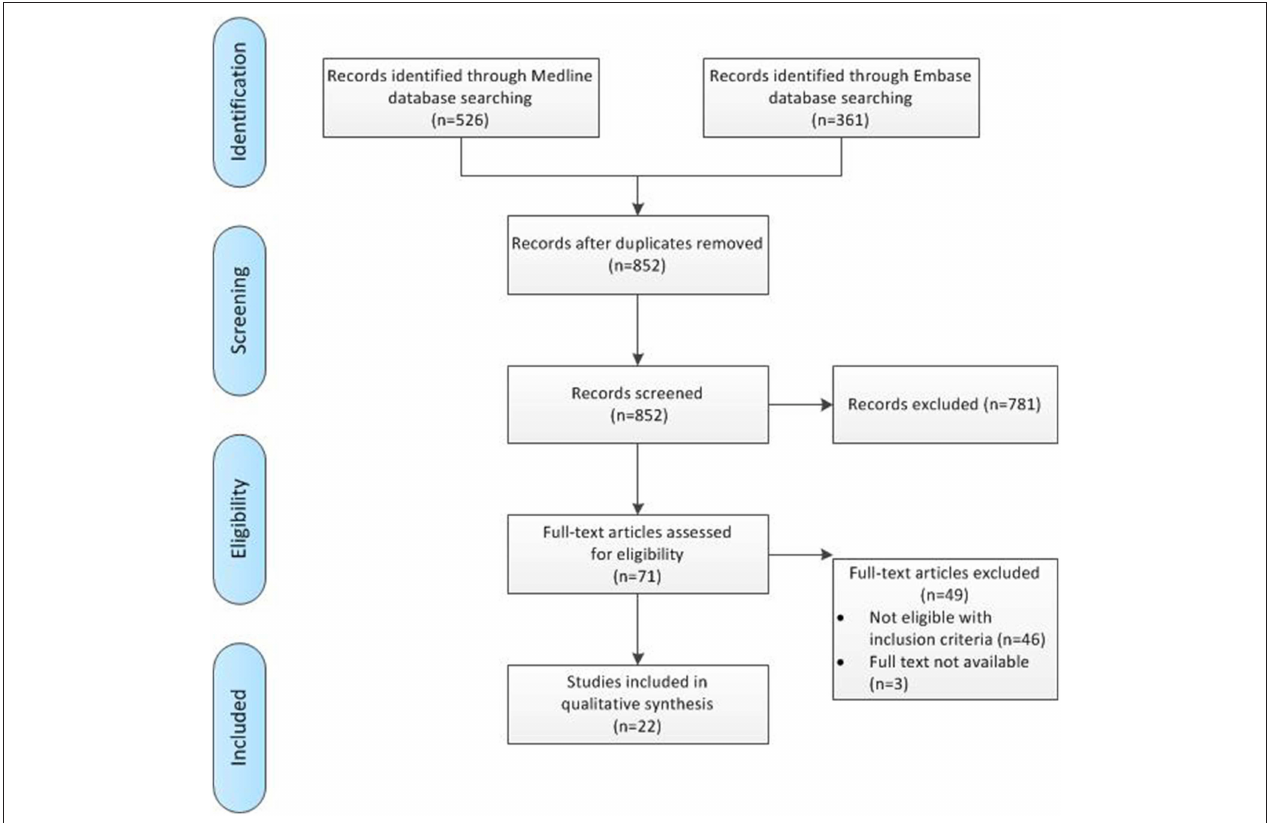
FIGURE 2 | Flowchart of clinical search